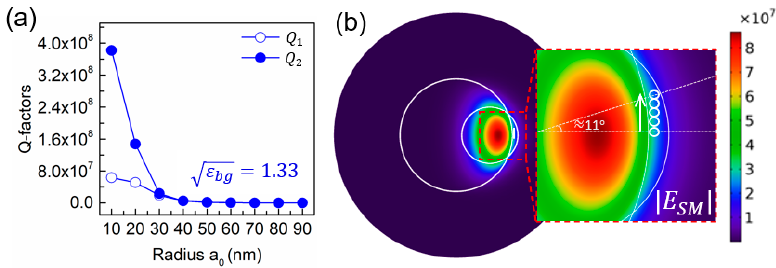
Figure 3. ( a ) Q-factors of the SM mode versus the radius a 0 . ( b ) Diagram of the five microtoroid-particle binding cases where the particle lands with five different polar angles moving away from the energy maximum of the whispering-gallery mode (WGM). The electric field units are arbitrary.